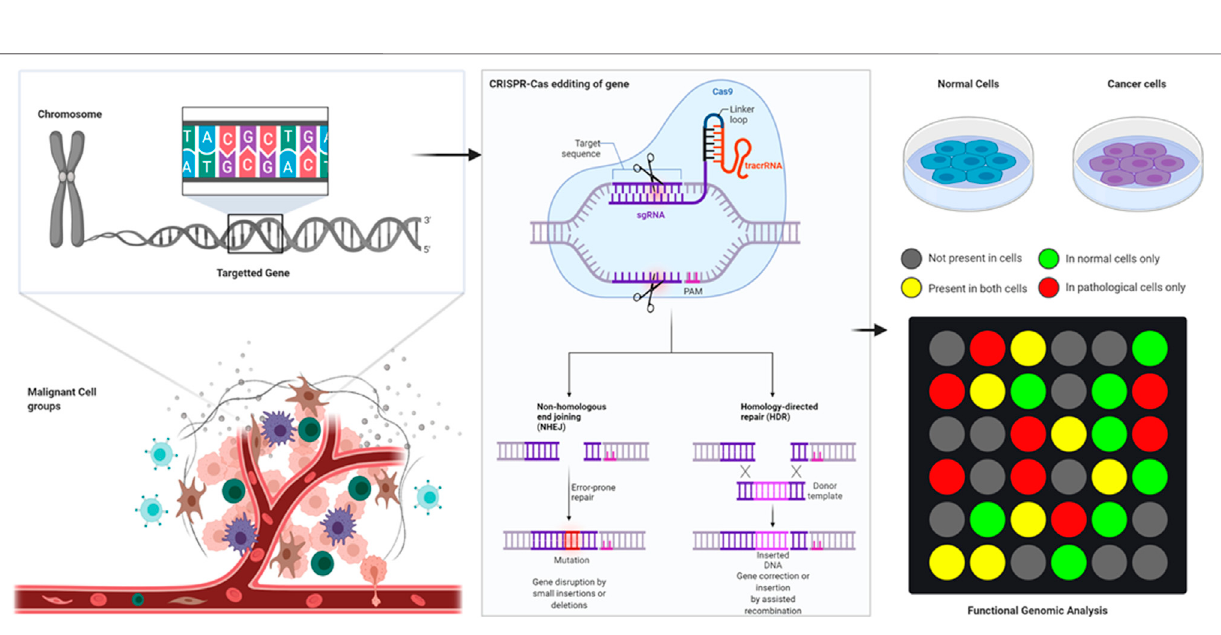
FIGURE 2 | Functional Genomic analysis of hematological malignancies using CRISPR